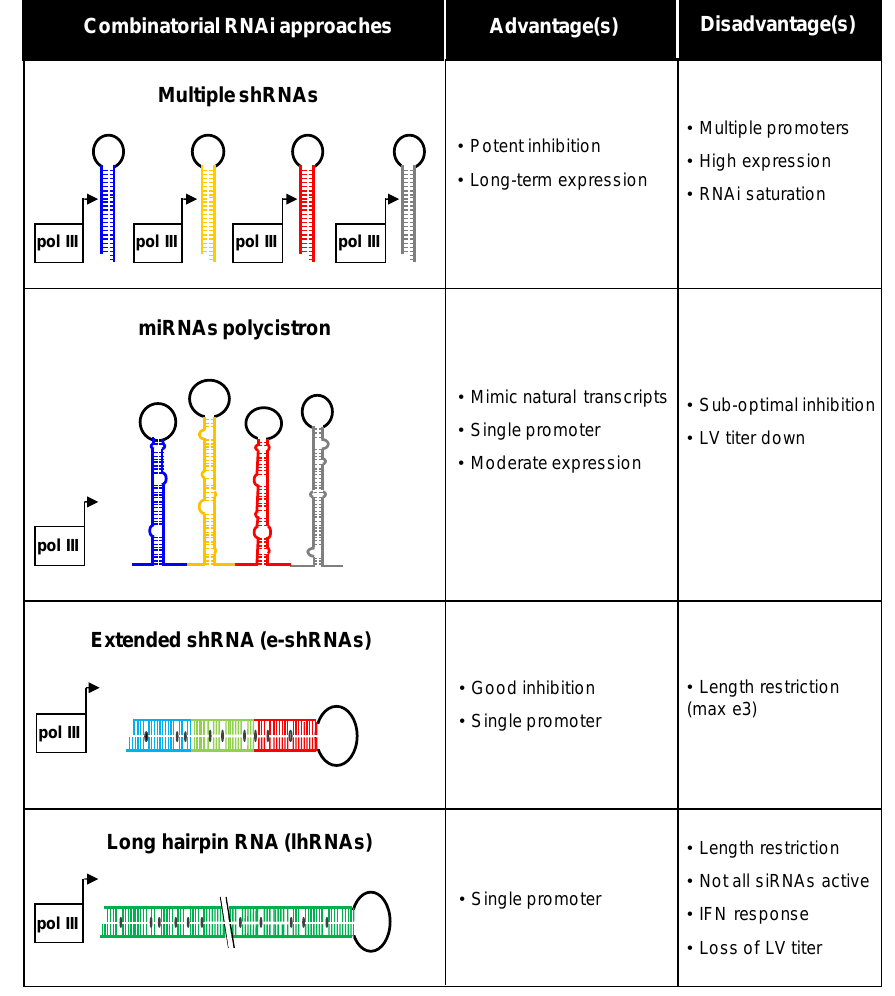
Figure 4. Combinatorial RNAi strategies. Four inhibitory scenarios are plotted with the respective advantages and disadvantages. This figure was adapted from [111]. LV: lentiviral vector.